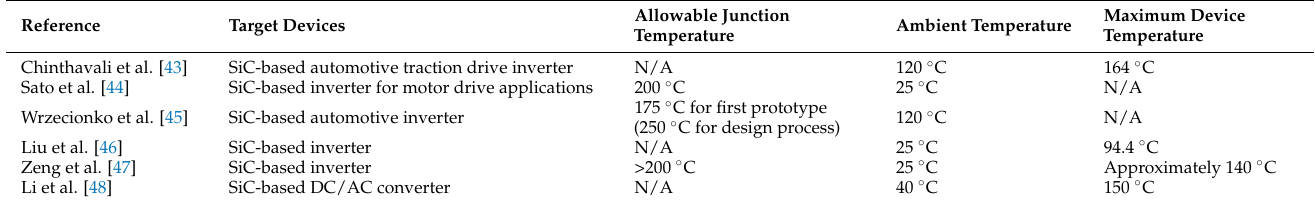
Table 4. Summary of studies focusing on the forced air cooling for automotive power